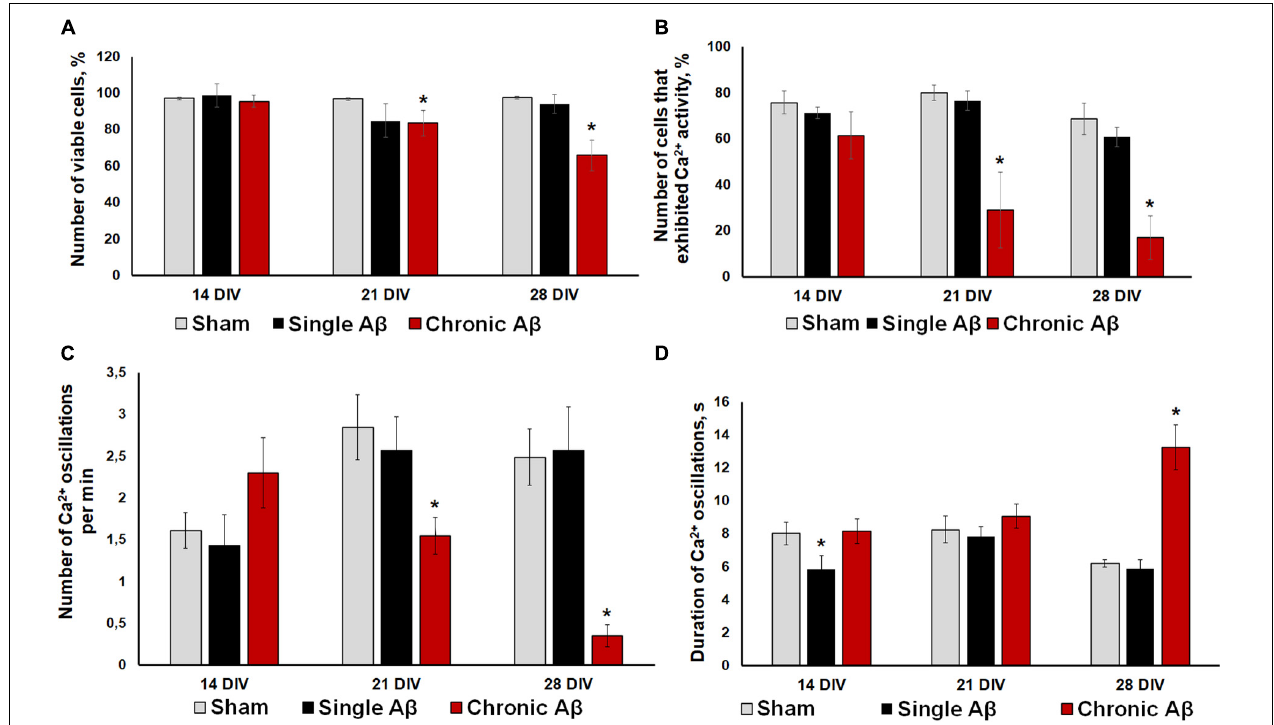
FIGURE 5 | (A) Analysis of cell viability in primary hippocampal cultures under single and chronic exogenous application of A β . * vs. “Sham,” p < 0.05, ANOVA. One application of A β did not affect primary culture viability, whereas its chronic application significant decreased the number of viable cells. (B–D) Main parameters of spontaneous calcium activity in primary hippocampal cultures under single and chronic A β application (B) Proportion of cells exhibiting Ca 2 + activity; (C) number of Ca 2 + oscillations per min; (D) duration of Ca 2 + oscillations. * vs. “Sham,” p < 0.05, ANOVA. One A β application did not cause a pronounced effect on Ca 2 + activity in neuron-glial networks. Severe Ca 2 + activity suppression under chronic A β application was observed from DIV